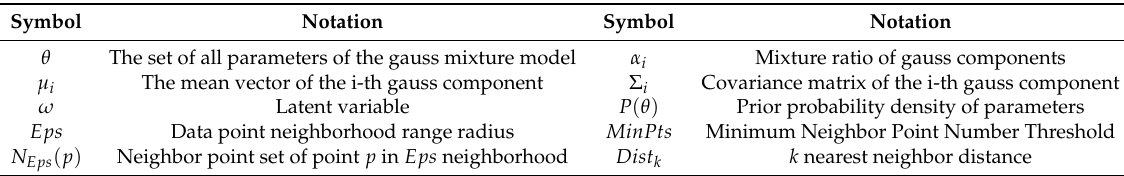
Table 1. Main symbol